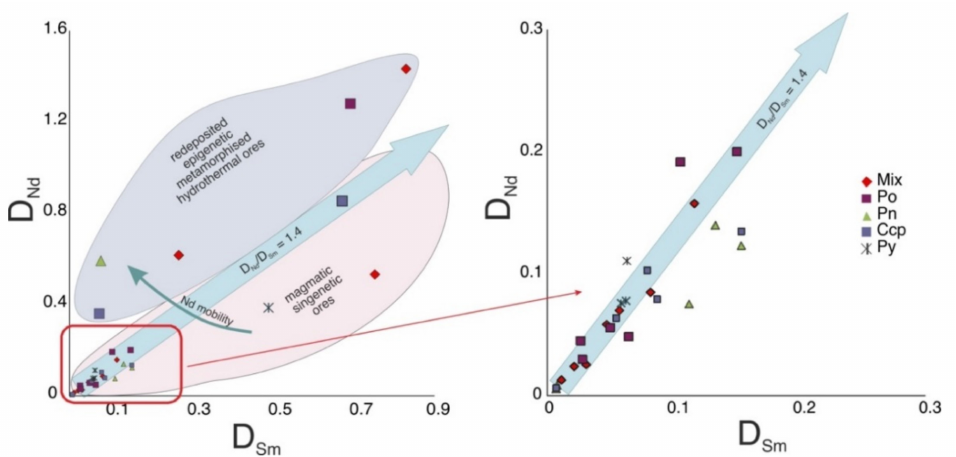
Figure 4. Partition coefficients D Nd -D Sm in various sulfide minerals from Cu-Ni-PGE complexes of the Fennoscandian Shield. Mix—mixture of sulfide concentrates, Po—pyrrhotite, Pn—pentlandite, Ccp—chalcopyrite, Py—pyrite.